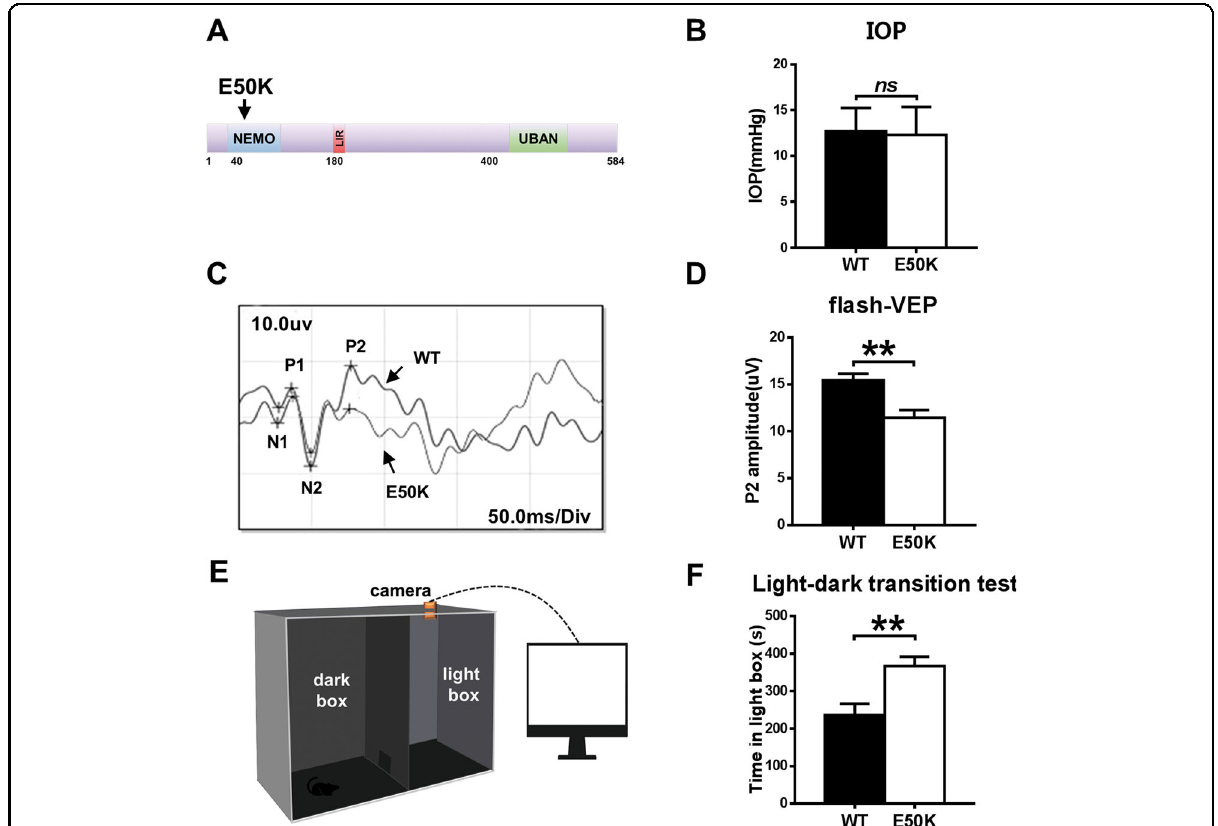
Fig. 1 Effects of the OPTN-E50K point mutation on visual function and IOP in vivo. A Various domains and the E50K mutation in mouse OPTN. NEMO NF-kappa-B essential modulator, LIR LC3-interacting region, UBD ubiquitin-binding domain. B IOP values in WT and E50K mutant mouse eyes. n = 17. C Representative recorded waveforms of F-VEP and D decreased amplitude of P2 following visual stimulation in E50K mutant mice compared with WT mice. n = 48. E , F The light/dark transition test was used to evaluate visual function, and E50K mutant mice spent more time in the light box than WT mice. n = 7. Data are presented as the means ± SEM; * P < 0.05; ** P <